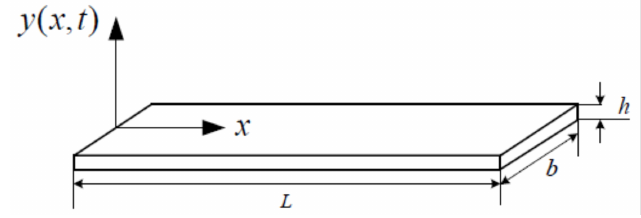
Figure 1. The geometric dimensions of the testing specimen.